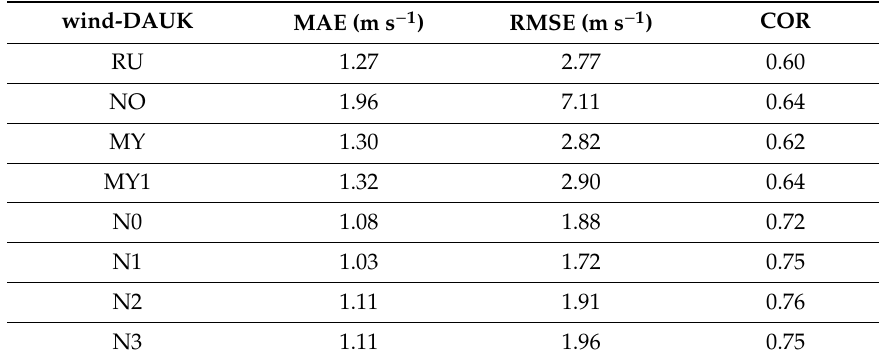
Table A5. Mean absolute error (MAE), root mean square error (RMSE), and correlation coe ffi cient (COR) for surface wind at Touggourt Sidi Mahd (Algeria); meteorological aviation reporting (METAR) station code = DAUK.